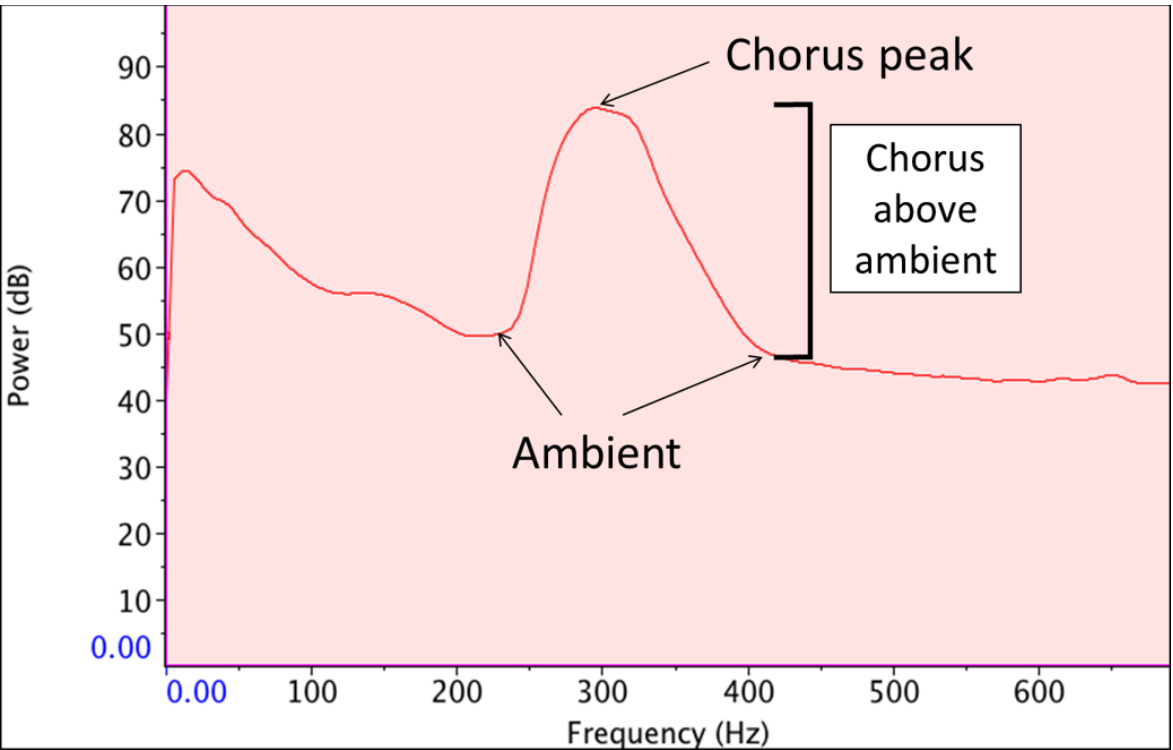
Figure A1.1. Depiction of the method used to extract boom chorus peak and ambient background noise sound pressure levels at ~ 0.300 kHz in the 383 usable recordings collected near Ainsworth, Brown County, Nebraska, USA in 2013 and 2014. The chorus peak and background sound levels at 50 m from the lek were used as the level of boom chorus (the source) originating from the lek and grassland cover type background noise, respectively, in each of the 383 chorus propagation maps generated with